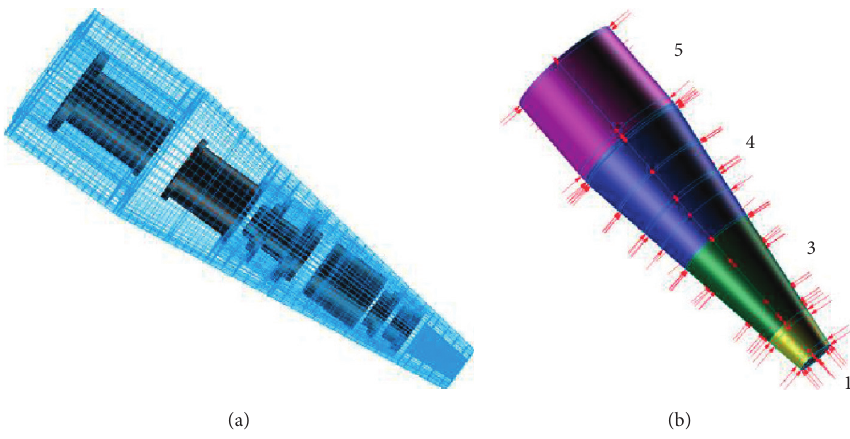
Figure 13: The model and load distribution of a reentry